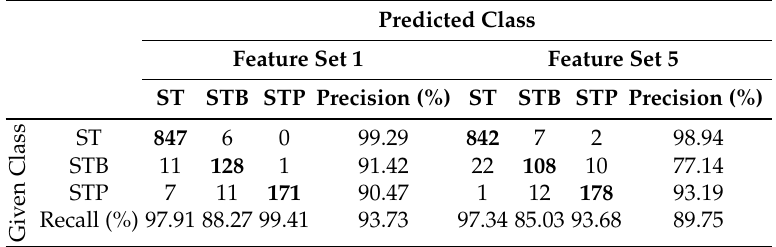
Table 11. Confusion metrics for fs1 and fs5 at the RH position achieved through KNN.